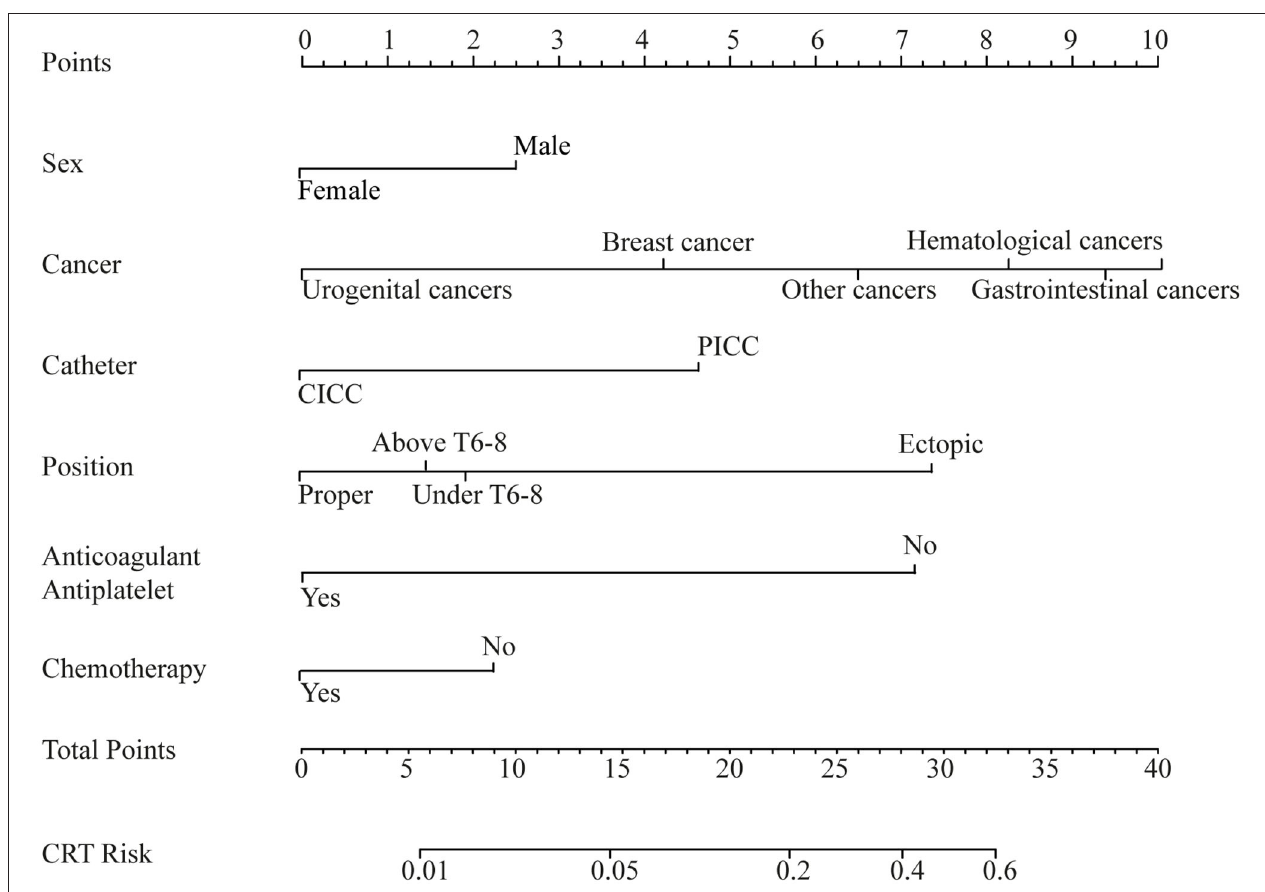
FIGURE 1 | Nomogram. Nomogram of the predicted catheter-related thrombosis (CRT) risk in cancer patients.